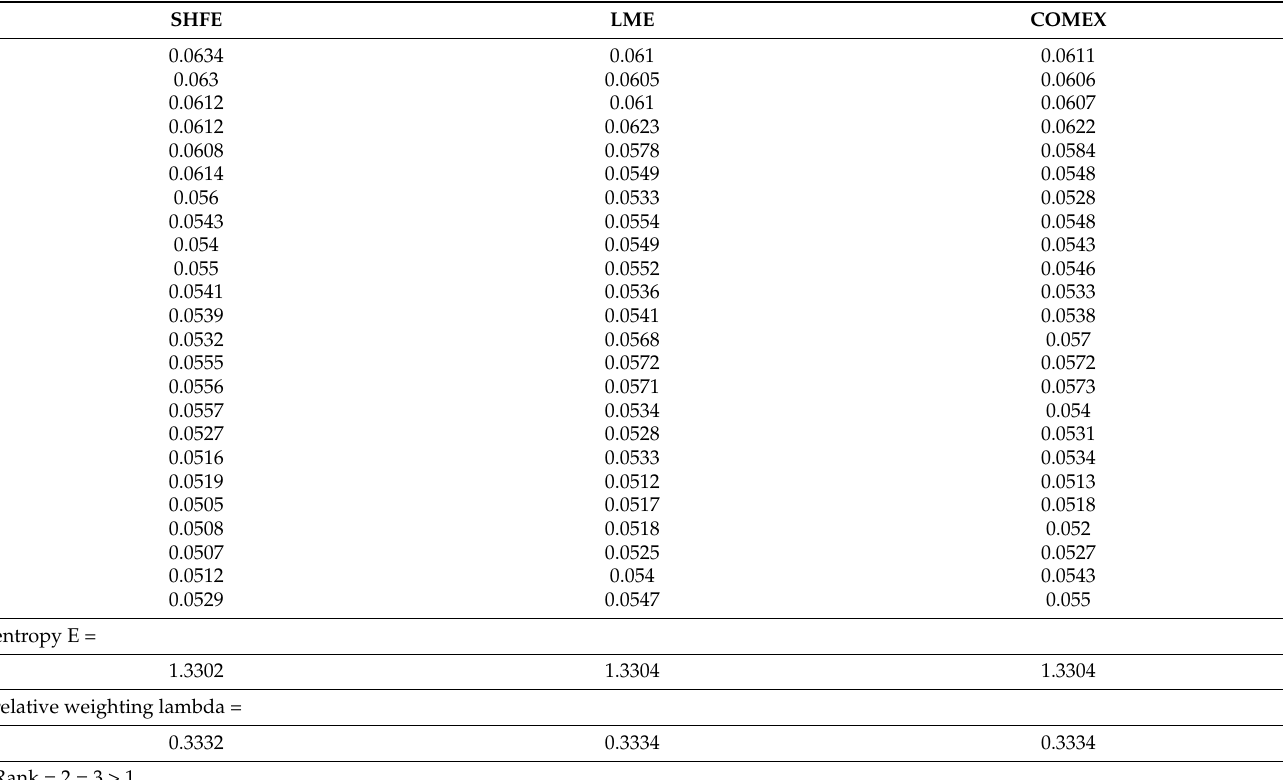
Table 2. Values from the processing of each factor after weighted analysis using grey entropy before the COVID-19 outbreak.